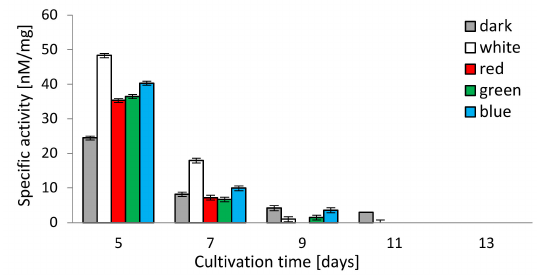
Figure 4. Chymotrypsin-like activity (CHT-L) of C. unicolor 26S proteasomes detected in the white, dark, red, blue and green light